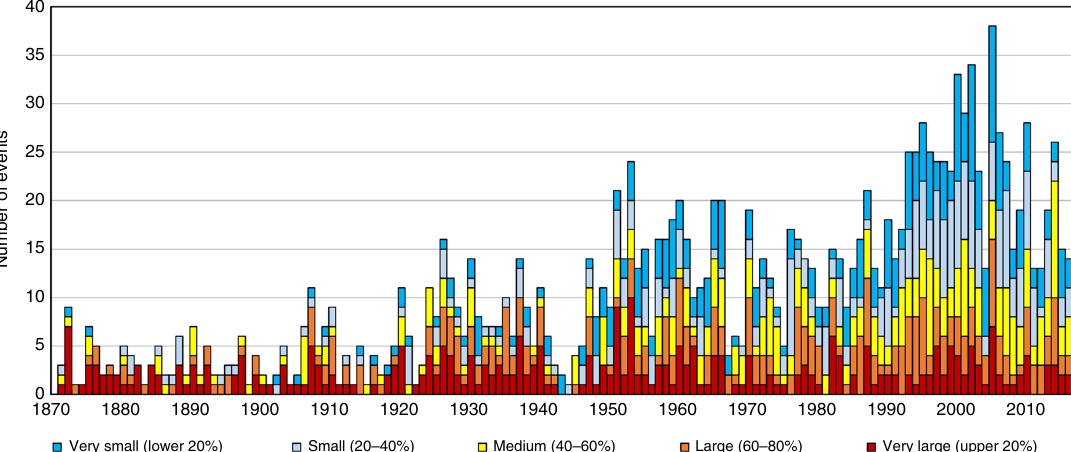
Fig. 5 Severity of fl oods. Annual number of fl ood events classi fi ed by severity into quintiles. Classi fi cation is based on normalized and gap- fi lled values of